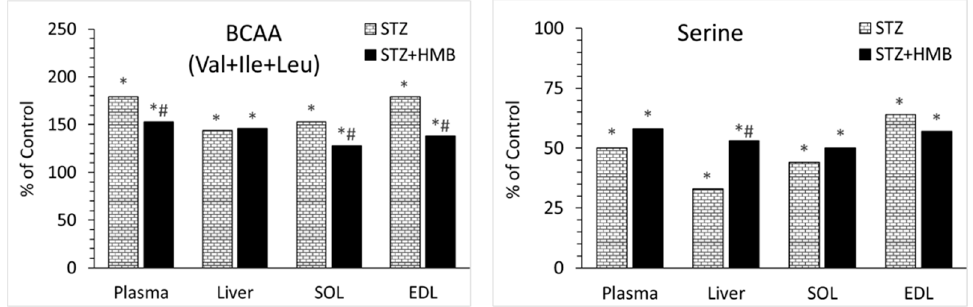
Figure 2. Effects of STZ and HMB on BCAA and serine concentrations in blood plasma, liver, and muscles. Means ± SE, p ˂ 0.05. ANOVA and Bonferroni multiple comparisons. * Comparison vs. Control. # Comparison of STZ + HMB vs. STZ.